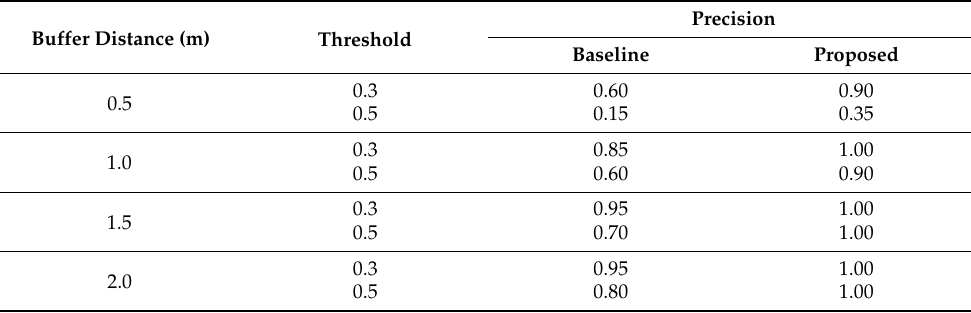
Figure 17. Precision curves of the proposed and compared methods, evaluated in study area B, with different IOUs under four buffer distance: ( a ) 0.5 m, ( b ) 1.0 m, ( c ) 1.5 m, ( d ) 2.0 m. The proposed method offers the highest precision for all four cases. Table 2. Evaluation results for landslide trail extraction in study area A, bold denotes the best results for each measurement.